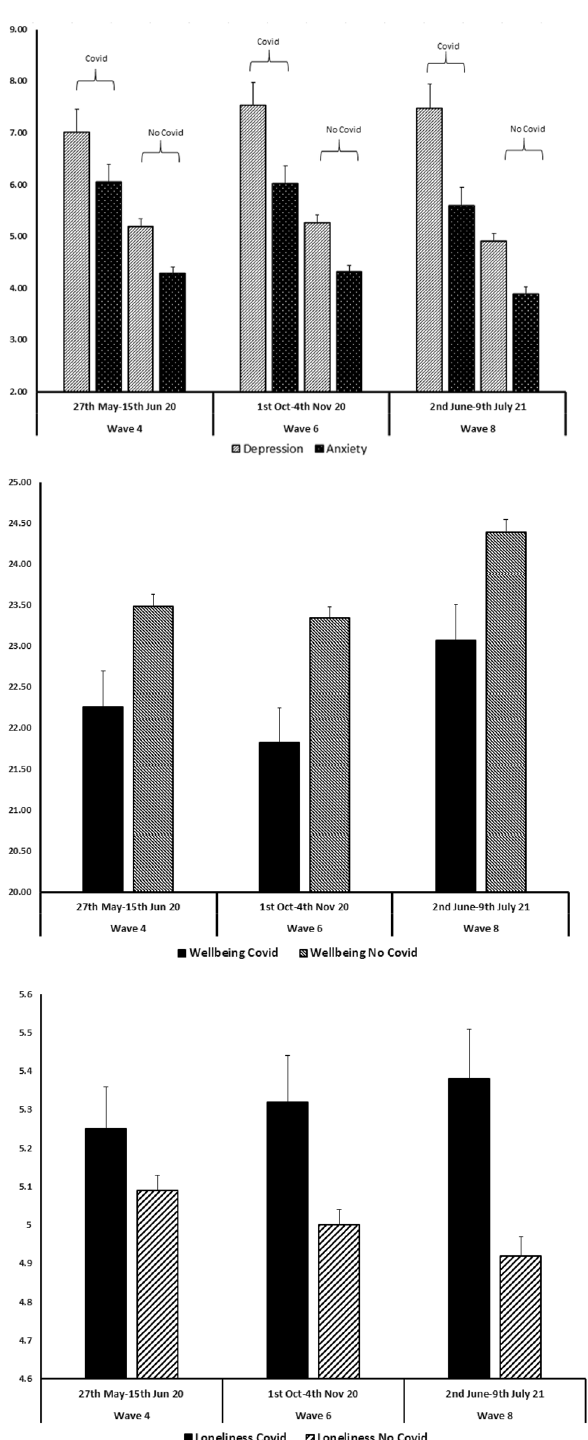
Figure 1. Mean mental health scores (top panel: depression and anxiety; middle panel: wellbeing; bottom panel: loneliness) at 1 month (May/June 2020), 5 month (Oct/Nov 2020) and 13 month (June/July 2021) follow up in individuals with and without COVID-19 at waves 1, 2 or